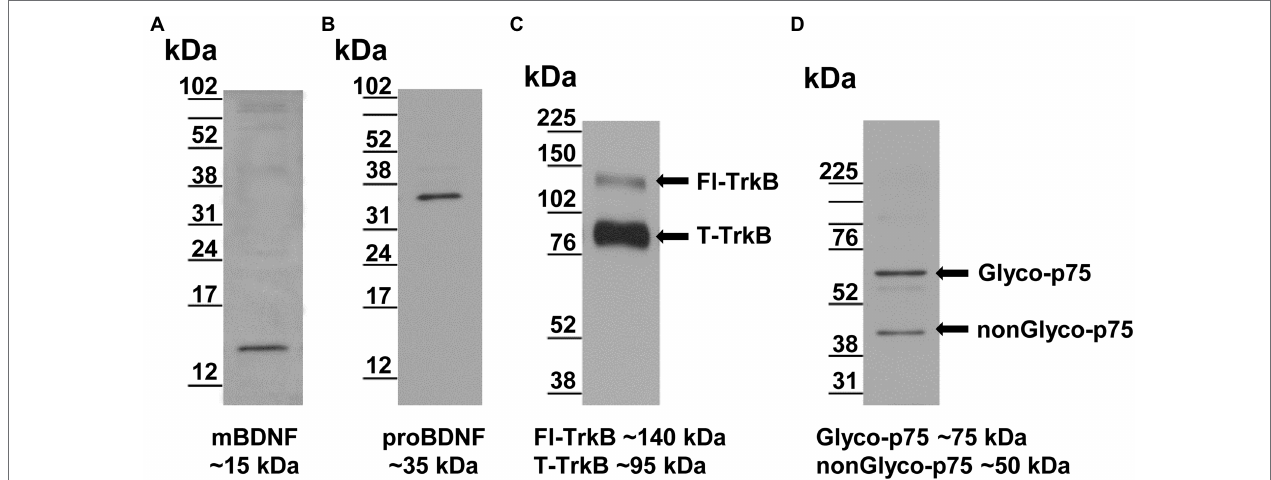
FIGURE 2 | Validation of antibodies by Western blotting of RVLM samples. (A) The rabbit BDNF antibody recognizes a single band consistent with reported molecular weight ~15 kDa (Seidah et al., 1996). (B) The rabbit proBDNF antibody recognizes a single band consistent with reported molecular weight of ~35 kDa (Seidah et al., 1996). (C) The goat TrkB antibody recognizes two TrkB isoforms consistent with reported molecular weights of ~140 and ~95 kDa for full length-form of TrkB (Fl-TrkB) and truncated form (T-TrkB), respectively (arrows; Klein et al., 1990; Escandon et al., 1994). (D) The rabbit p75 antibody representing the reported glycosylated (Glyco-p75, ~75 kDa) and non-glycosylated (nonGlyco-p75, ~50 kDa) forms, respectively (arrows; Grob et al., 1985; Kanning et al.,